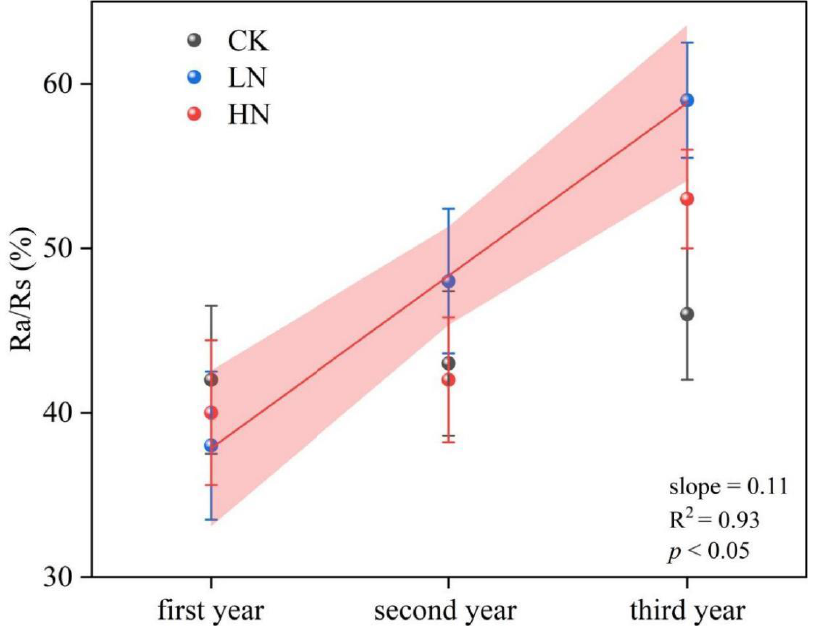
Figure 4. Gradual changes in the ratio of autotrophic respiration to soil respiration (Ra/Rs). Red lines indicate fitted regression, and light pink areas around the regression lines indicate 95% confidence intervals. Data are presented in terms of mean ± standard deviation values. CK, LN, and HN represent control, low, and high nitrogen applications, respectively.